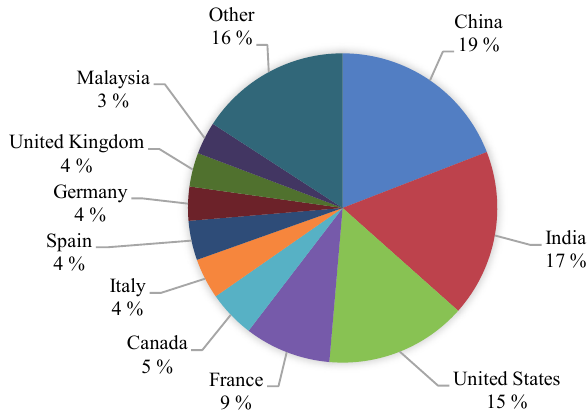
Fig. 2. Published documents in Scopus on topic of biobased epoxy by country.